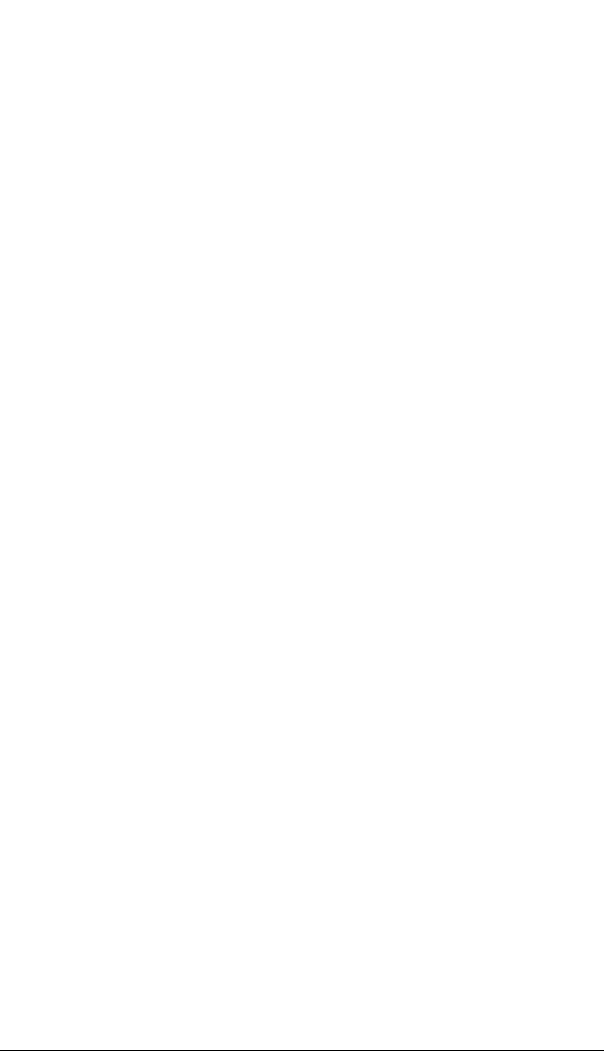
FIGUREA2 | Specificity of antisera. Recognition of the antigens by the corresponding antisera demonstrated by immunoprecipitation. CA2a (lanes 1 and 2) andTlCA15-FLAG (lanes 3 and 4) were translated in vitro in the presence of [ 35 S]methionine and [ 35 S]cysteine.The labeled proteins were subjected to immunoprecipitation with anti-CA2a antiserum (lane 1, Ab), anti-TuCA15a antiserum (lane 3, Ab), or corresponding preimmune serum (lanes 2 and 4, Pre).The immunoprecitates were analyzed by SDS–PAGE followed by autoradiography. Arrow indicates the position of the band corresponding toTlCA15-FLAG, indicating crossreactivity of anti-TuCA15a